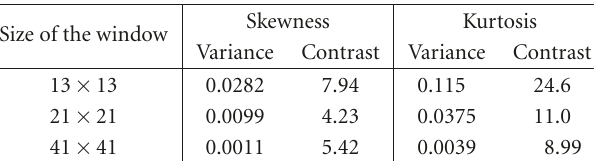
Table 1: Detection performances of the HOS (variance of the back- ground and contrast), with an SNR of − 60 dB, in function of the size of the computation window.